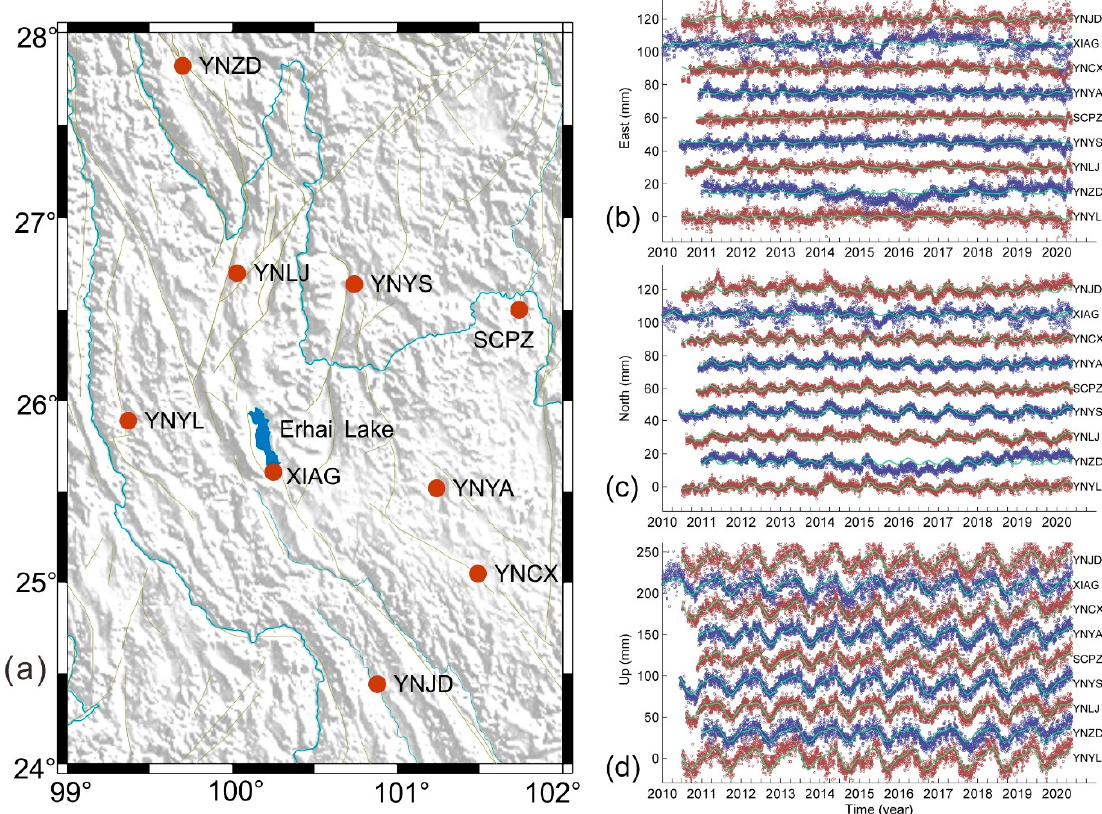
Figure 1. ( a ) Locations of cGPS stations (solid red circles) in the northwest Yunnan, and detrended GPS position time series for ( b ) east, ( c ) north, and ( d ) vertical components, respectively. The green curves show the seasonal variations modeled with annual and semi-annual harmonics.